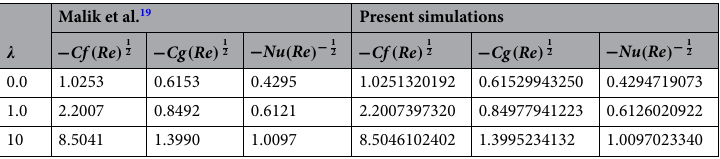
Table 3. Validation of numerical simulations in term of skin friction coefficients and heat transfer rate with published work 19 when ph 1